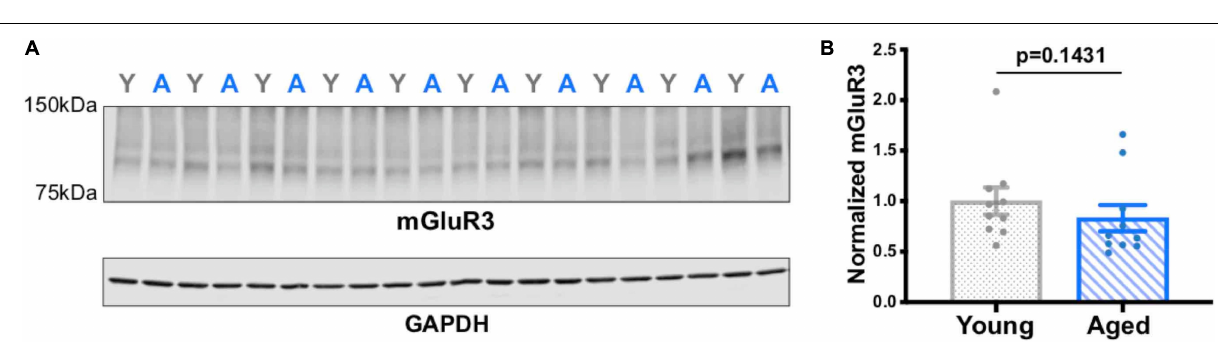
FIGURE 5 | mGluR3 levels in young vs. aged rat frontal cortex. (A) Rat frontal cortical tissue (15 µ g of protein loaded per well) was immunoblotted for mGluR3 and GAPDH. Each lane represents a single animal and is labeled either young (gray Y) or aged (blue A). (B) Quantification of mGluR3 normalized by GAPDH grouped by age. The young animals ( n = 10) and aged animals ( n = 10) were compared via a Mann-Whitney test ( p = 0.1431). SEM is plotted for each